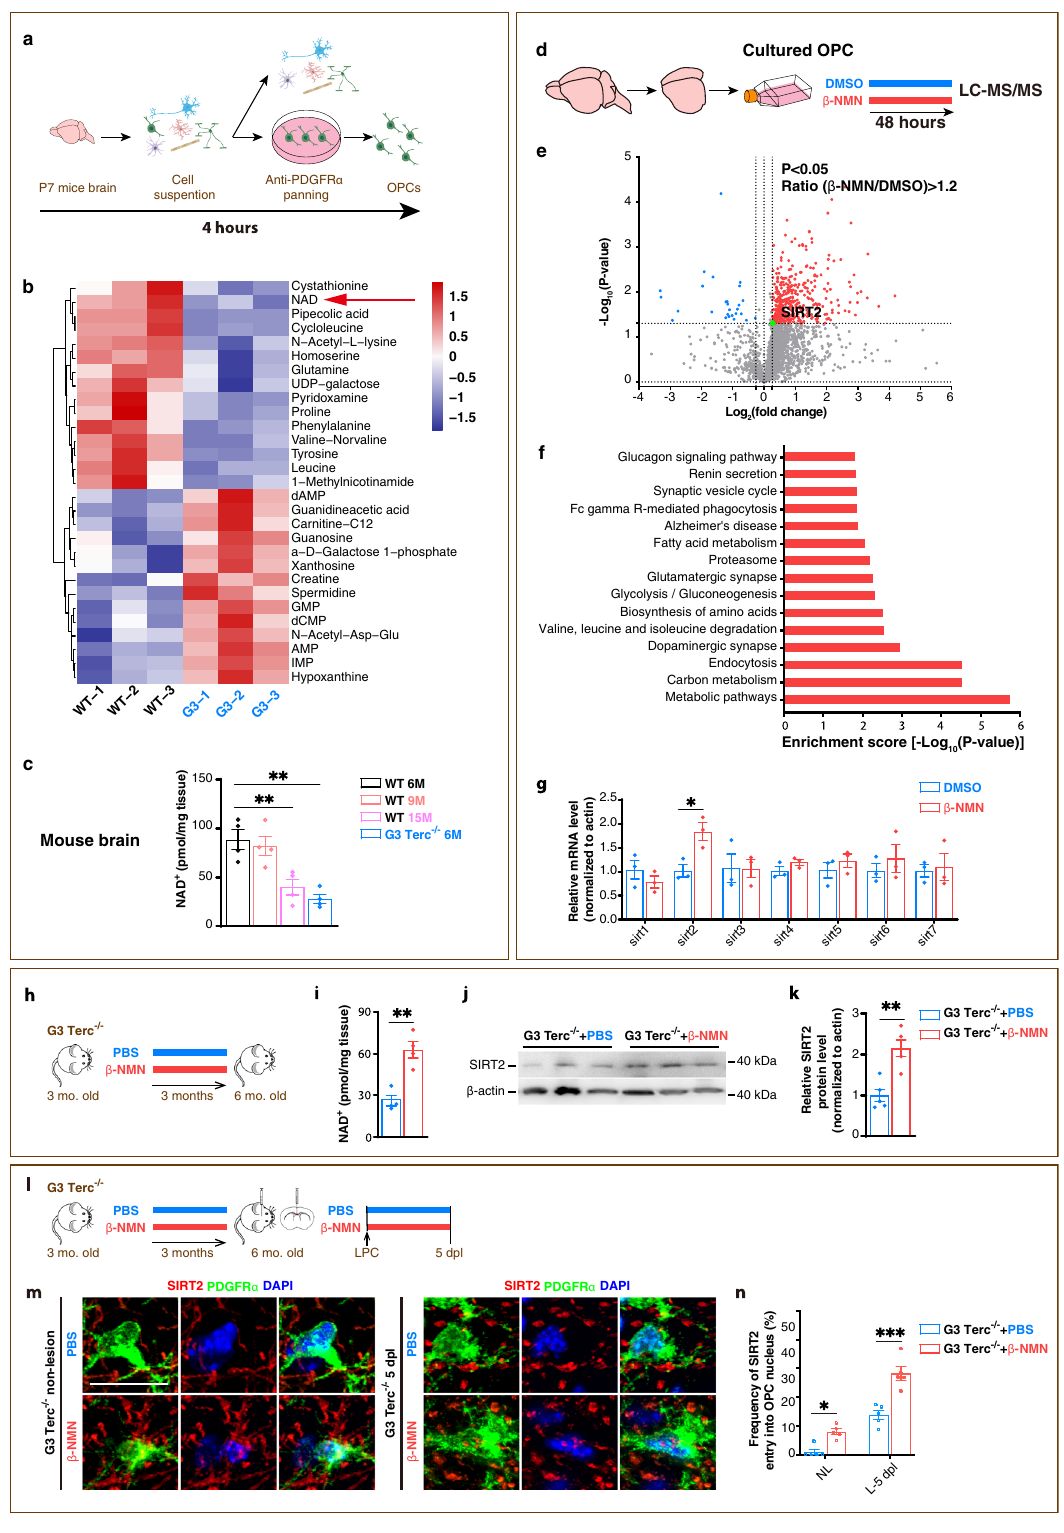
Fig. 5n). These results con fi rmed that NAD + repletion enhances remyelination ef fi ciency in G3 Terc − / − mice. Furthermore, NAD + repletion also decreased both the G-Ratio (Fig. 5o – p) and the distance between DL (Fig. 5q, r), indicating that NAD + not only increases the thickness of newly-formed myelin but also makes it more